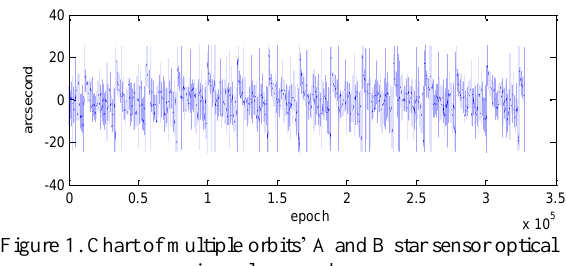
Figure 1. Chart of multiple orbits’ A and B star sensor optical